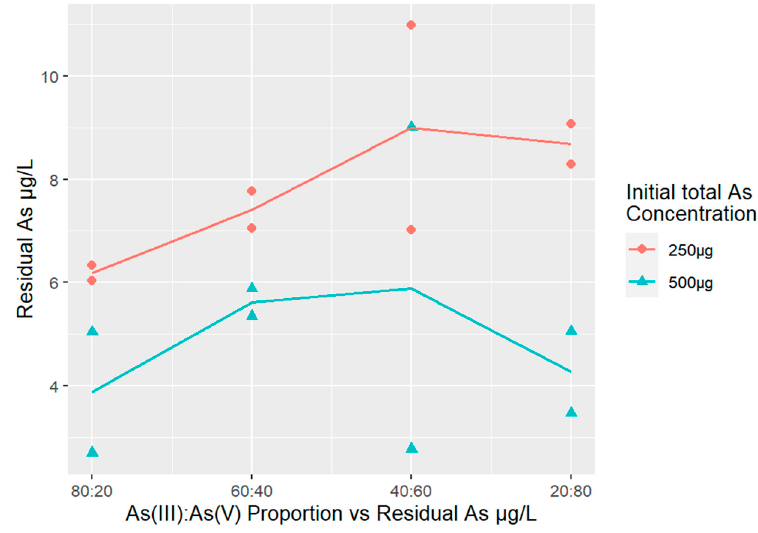
Figure 4. Residual arsenic concentration after treating four As(III):As(V) proportions at a total concentration of 250 µg L − 1 (dots) and 500 µg L − 1 (triangles) with two repetitions. Lines connect the mean values (6.19, 7.41, 9.00, and 8.68 for a concentration of 250 µg L − 1 and 3.88, 5.61, 5.89, and 4.27 for a concentration of 500 µg L − 1 ). Fe(VI) and Fe(III) dosage of 1 mg L − 1 and 30 mg L − 1 , respectively.